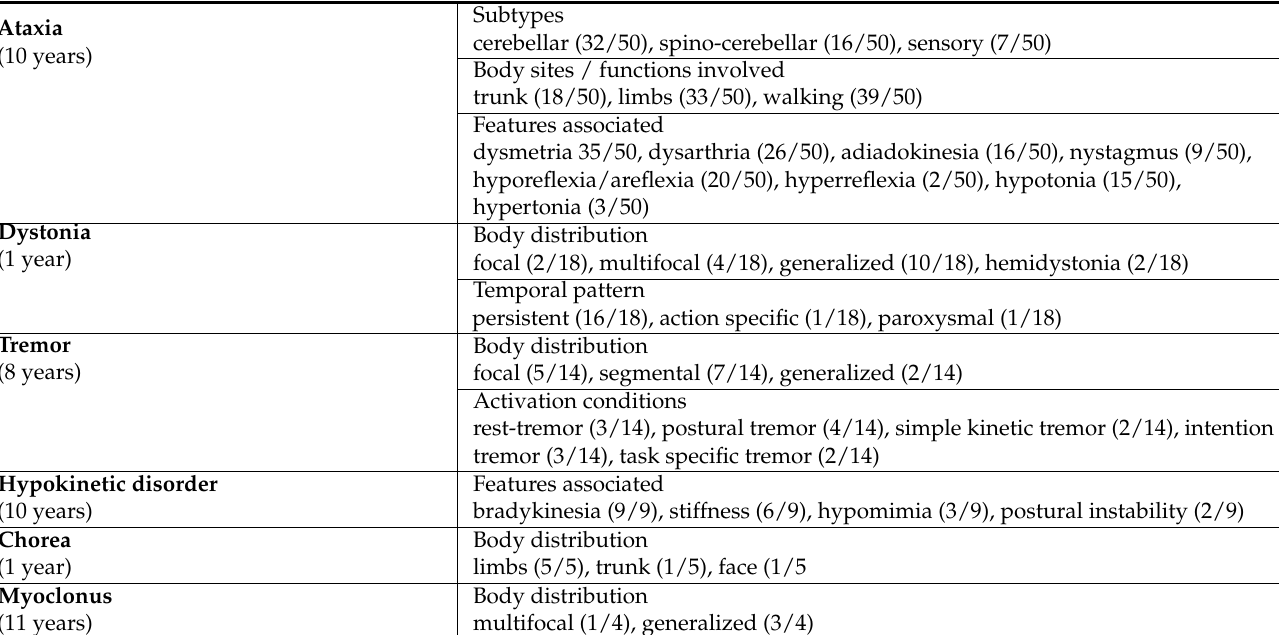
Table 4. Clinical features at onset of each type of movement disorder and their median age at onset.